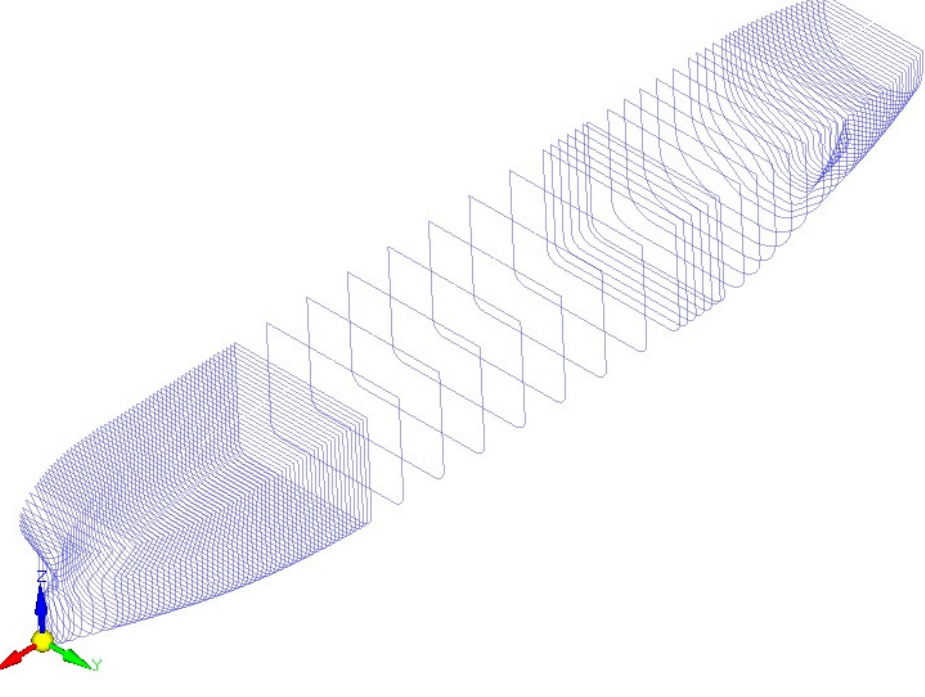
Figure 3. Ship hull wireframe model.